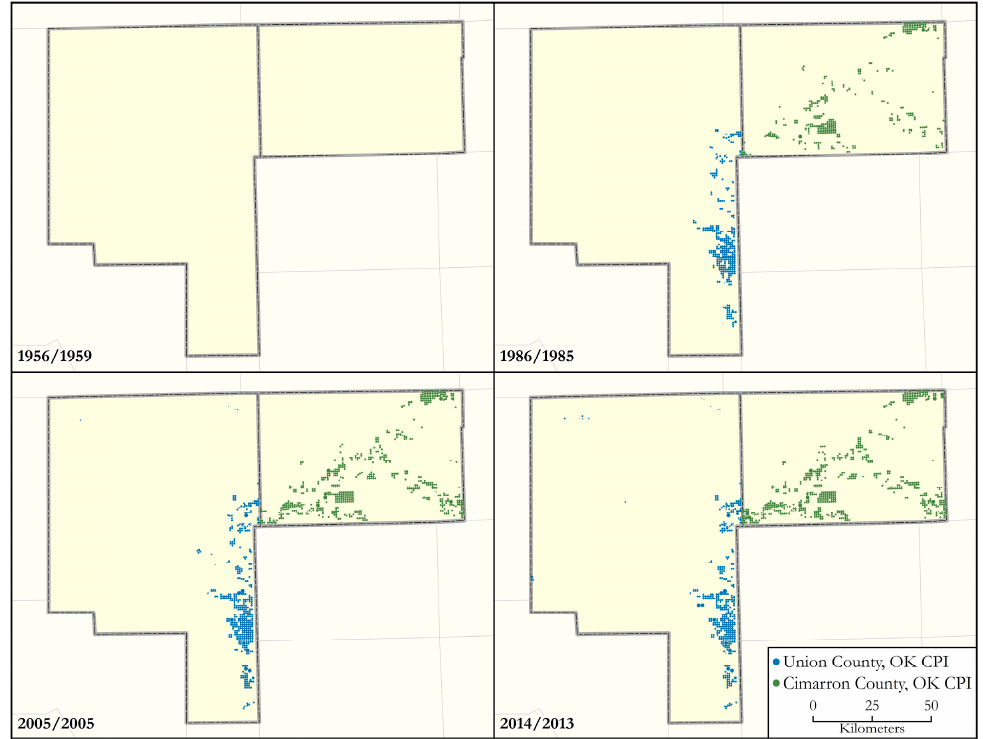
Figure 2. Growth of center pivot irrigation systems in the study area, 1955–2014. The years on the left indicate the aerial photography year for Union County, NM, while those on the right represent the aerial photography year for Cimarron County, OK.